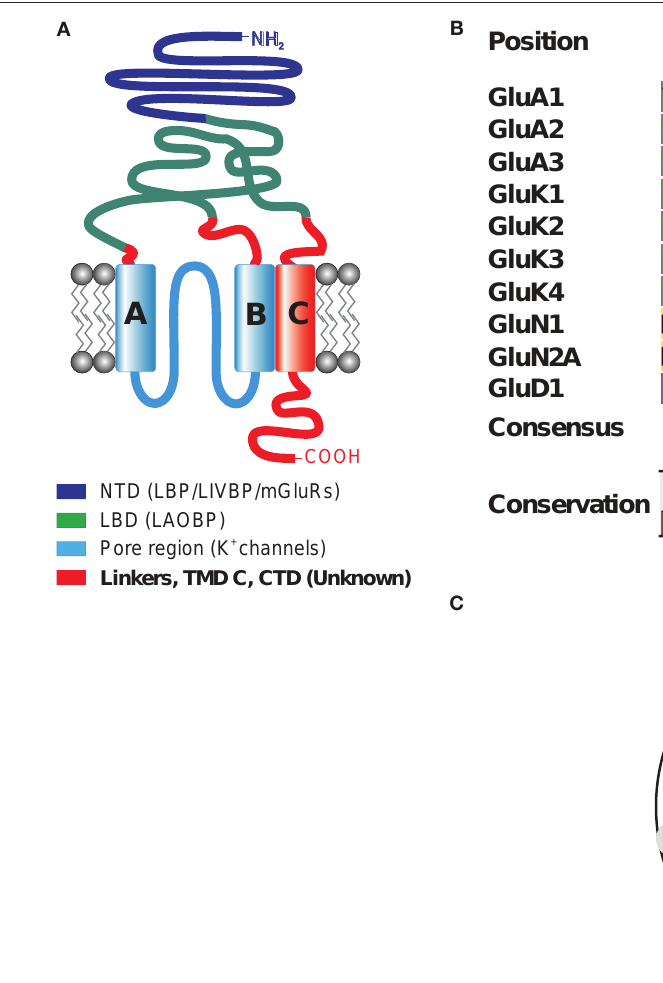
the linker regions, the TMD C, and the CTD no homologous sequences have been identified. (B) Local sequence alignment of the TMD C regions of all iGluR subunits that were used as TMD C donors in domain transplantation constructs. Two residues, G790 and F792 are conserved among all 18 iGluR subunits. Residues that were altered in this study are indicated by asterisks. (C) Helical wheel representation of the TMD C of GluA1. Residues investigated in this study are encircled in red. Numbering refers to the mature GluA1 sequence, without the signal